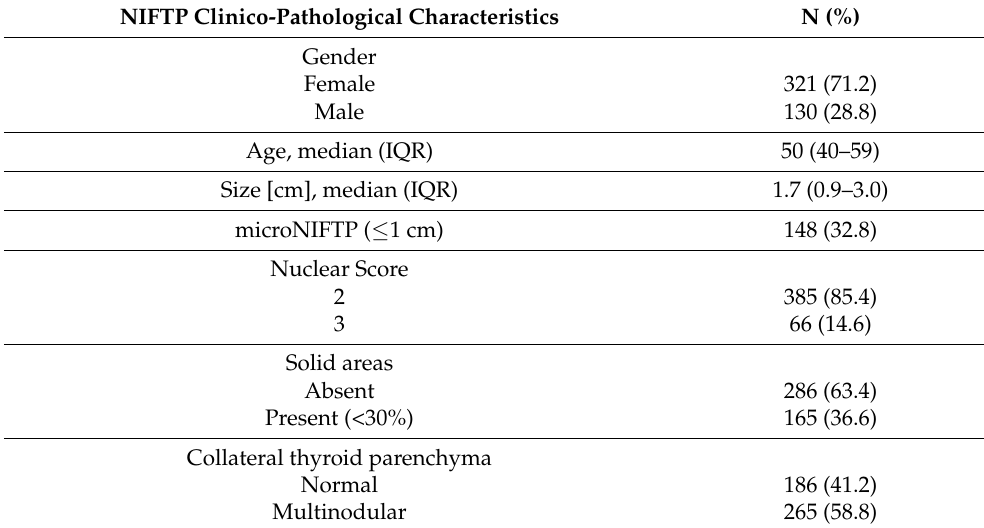
Table 1. Description of 451 NIFTP cases. NIFTP Clinico-Pathological